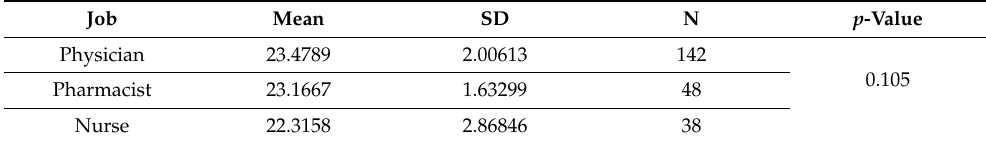
Table 2. Statistical comparison of healthcare workers’ perception scores.